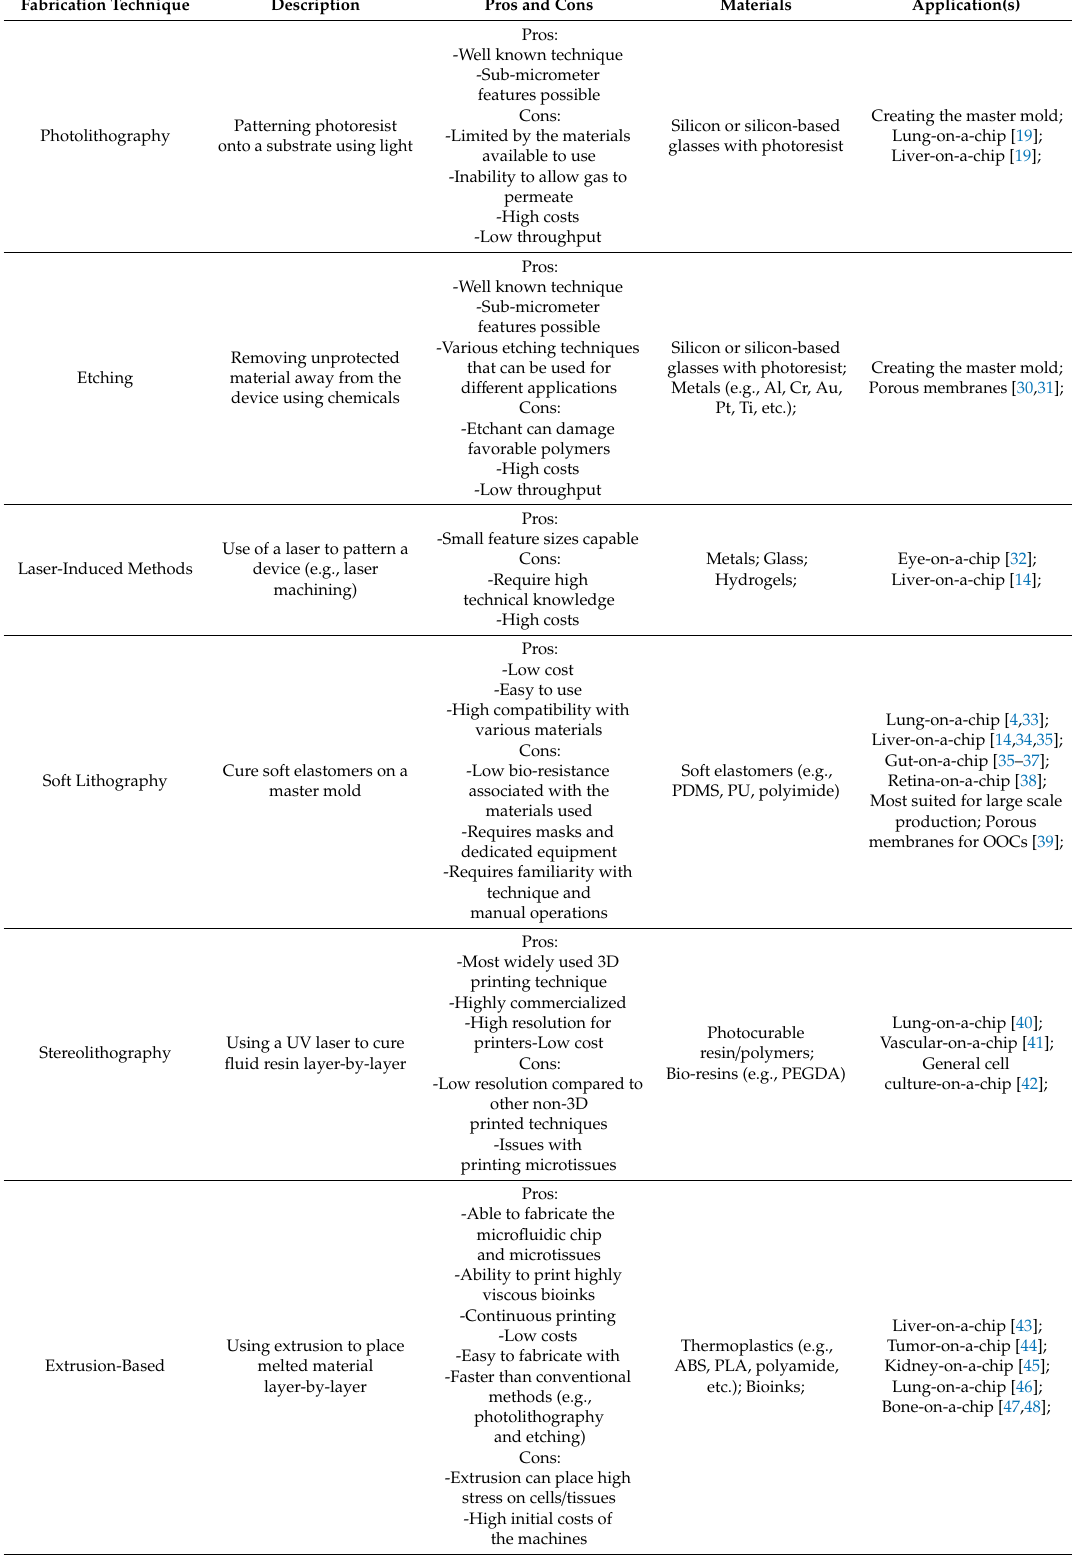
Table 1. A brief overview of the fabrication methods used to create